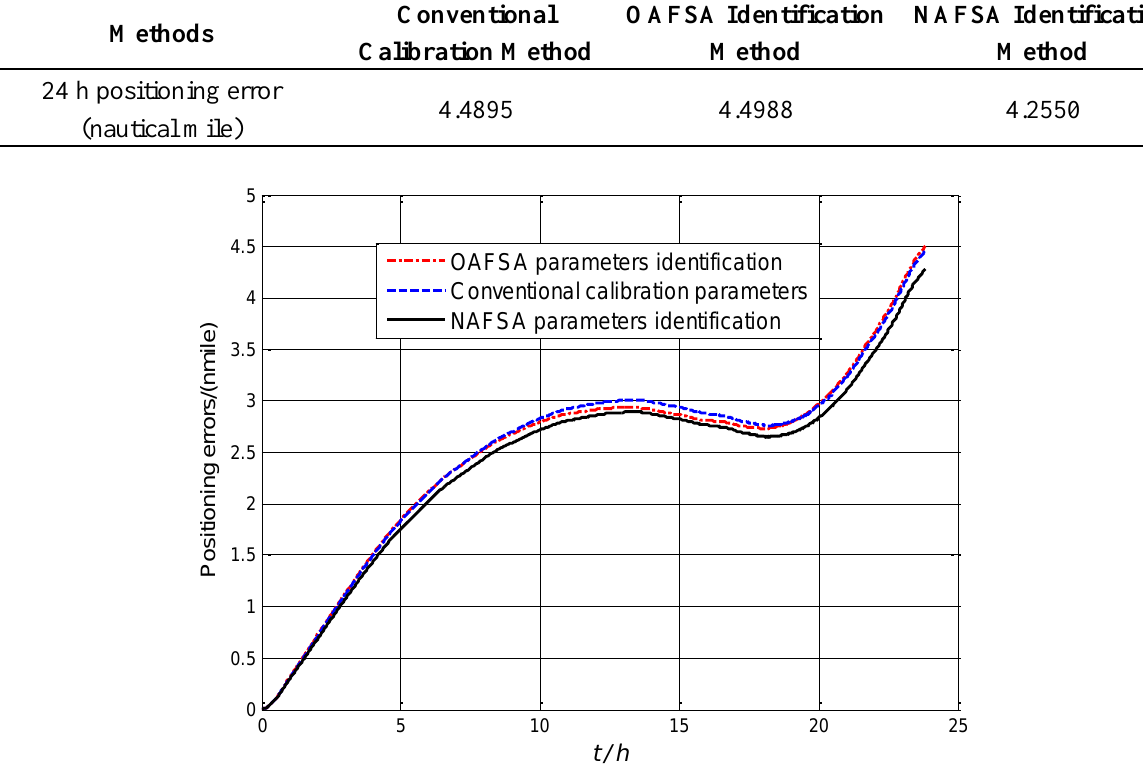
Figure 6. The comparison of positioning error with three methods.